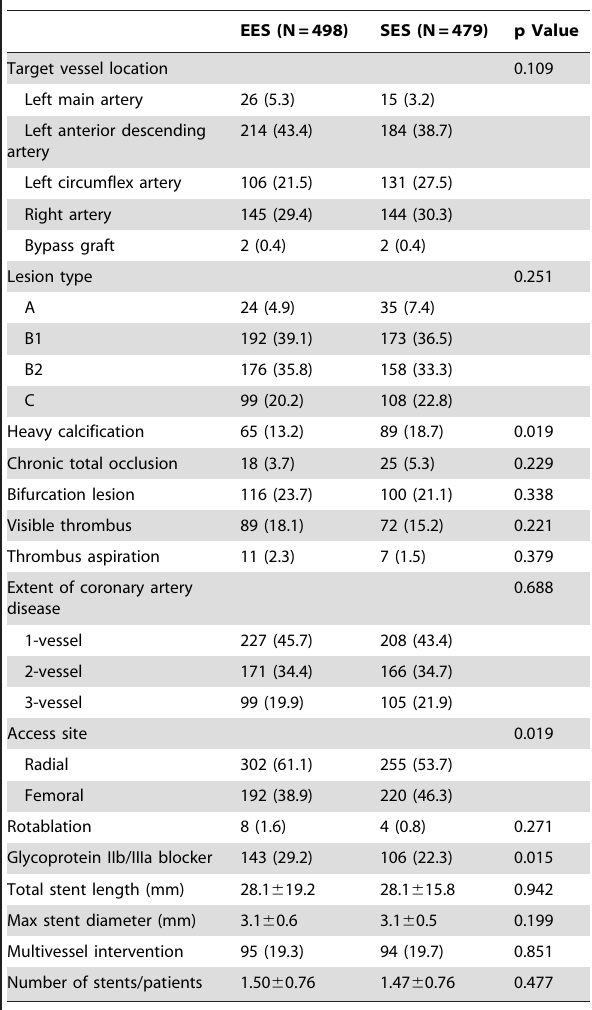
Table 2. Angiographic and procedural